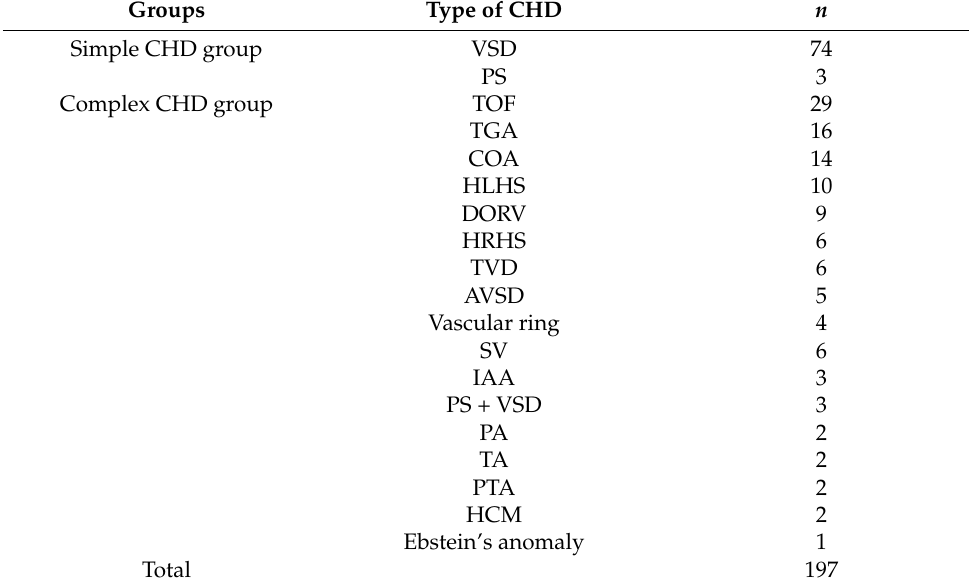
Table 1. Antenatal cardiac finding in all cases of CHD. Groups